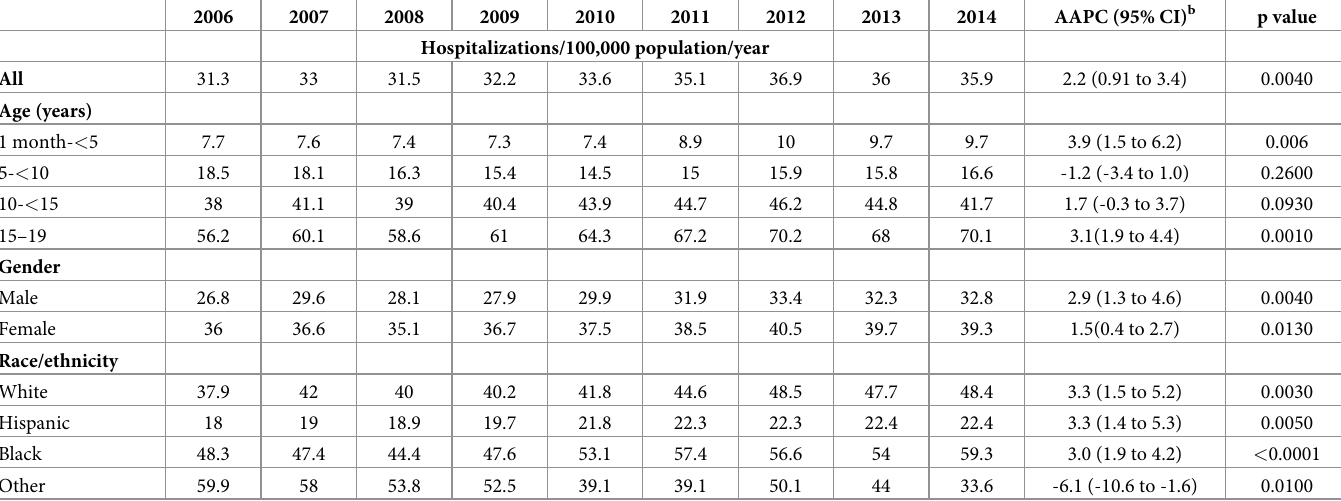
Table 2. Temporal trends of population-adjusted rates of hospitalization with diabetic ketoacidosis in Texas a .